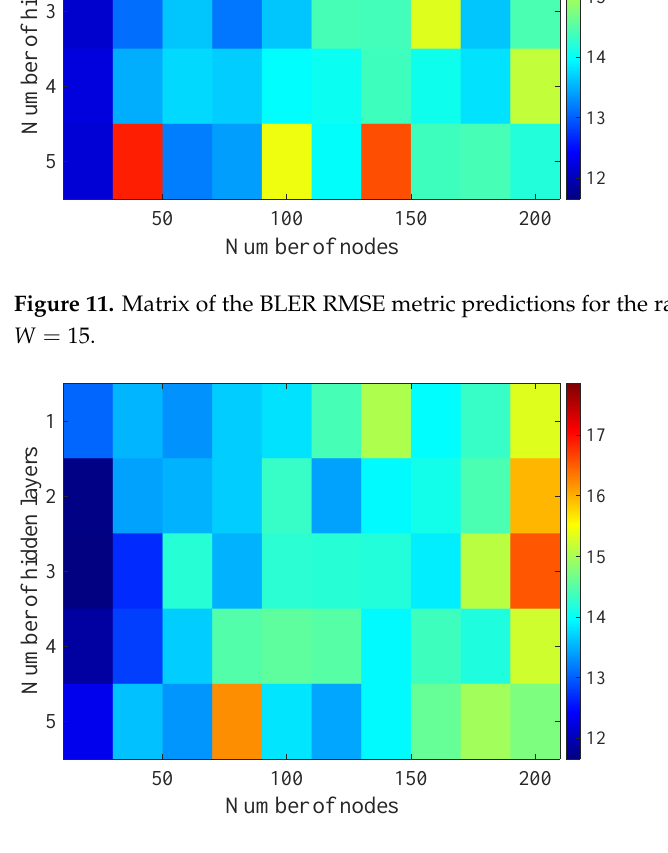
Figure 12. Matrix of the BLER RMSE metric predictions for the radio parameters history window W =